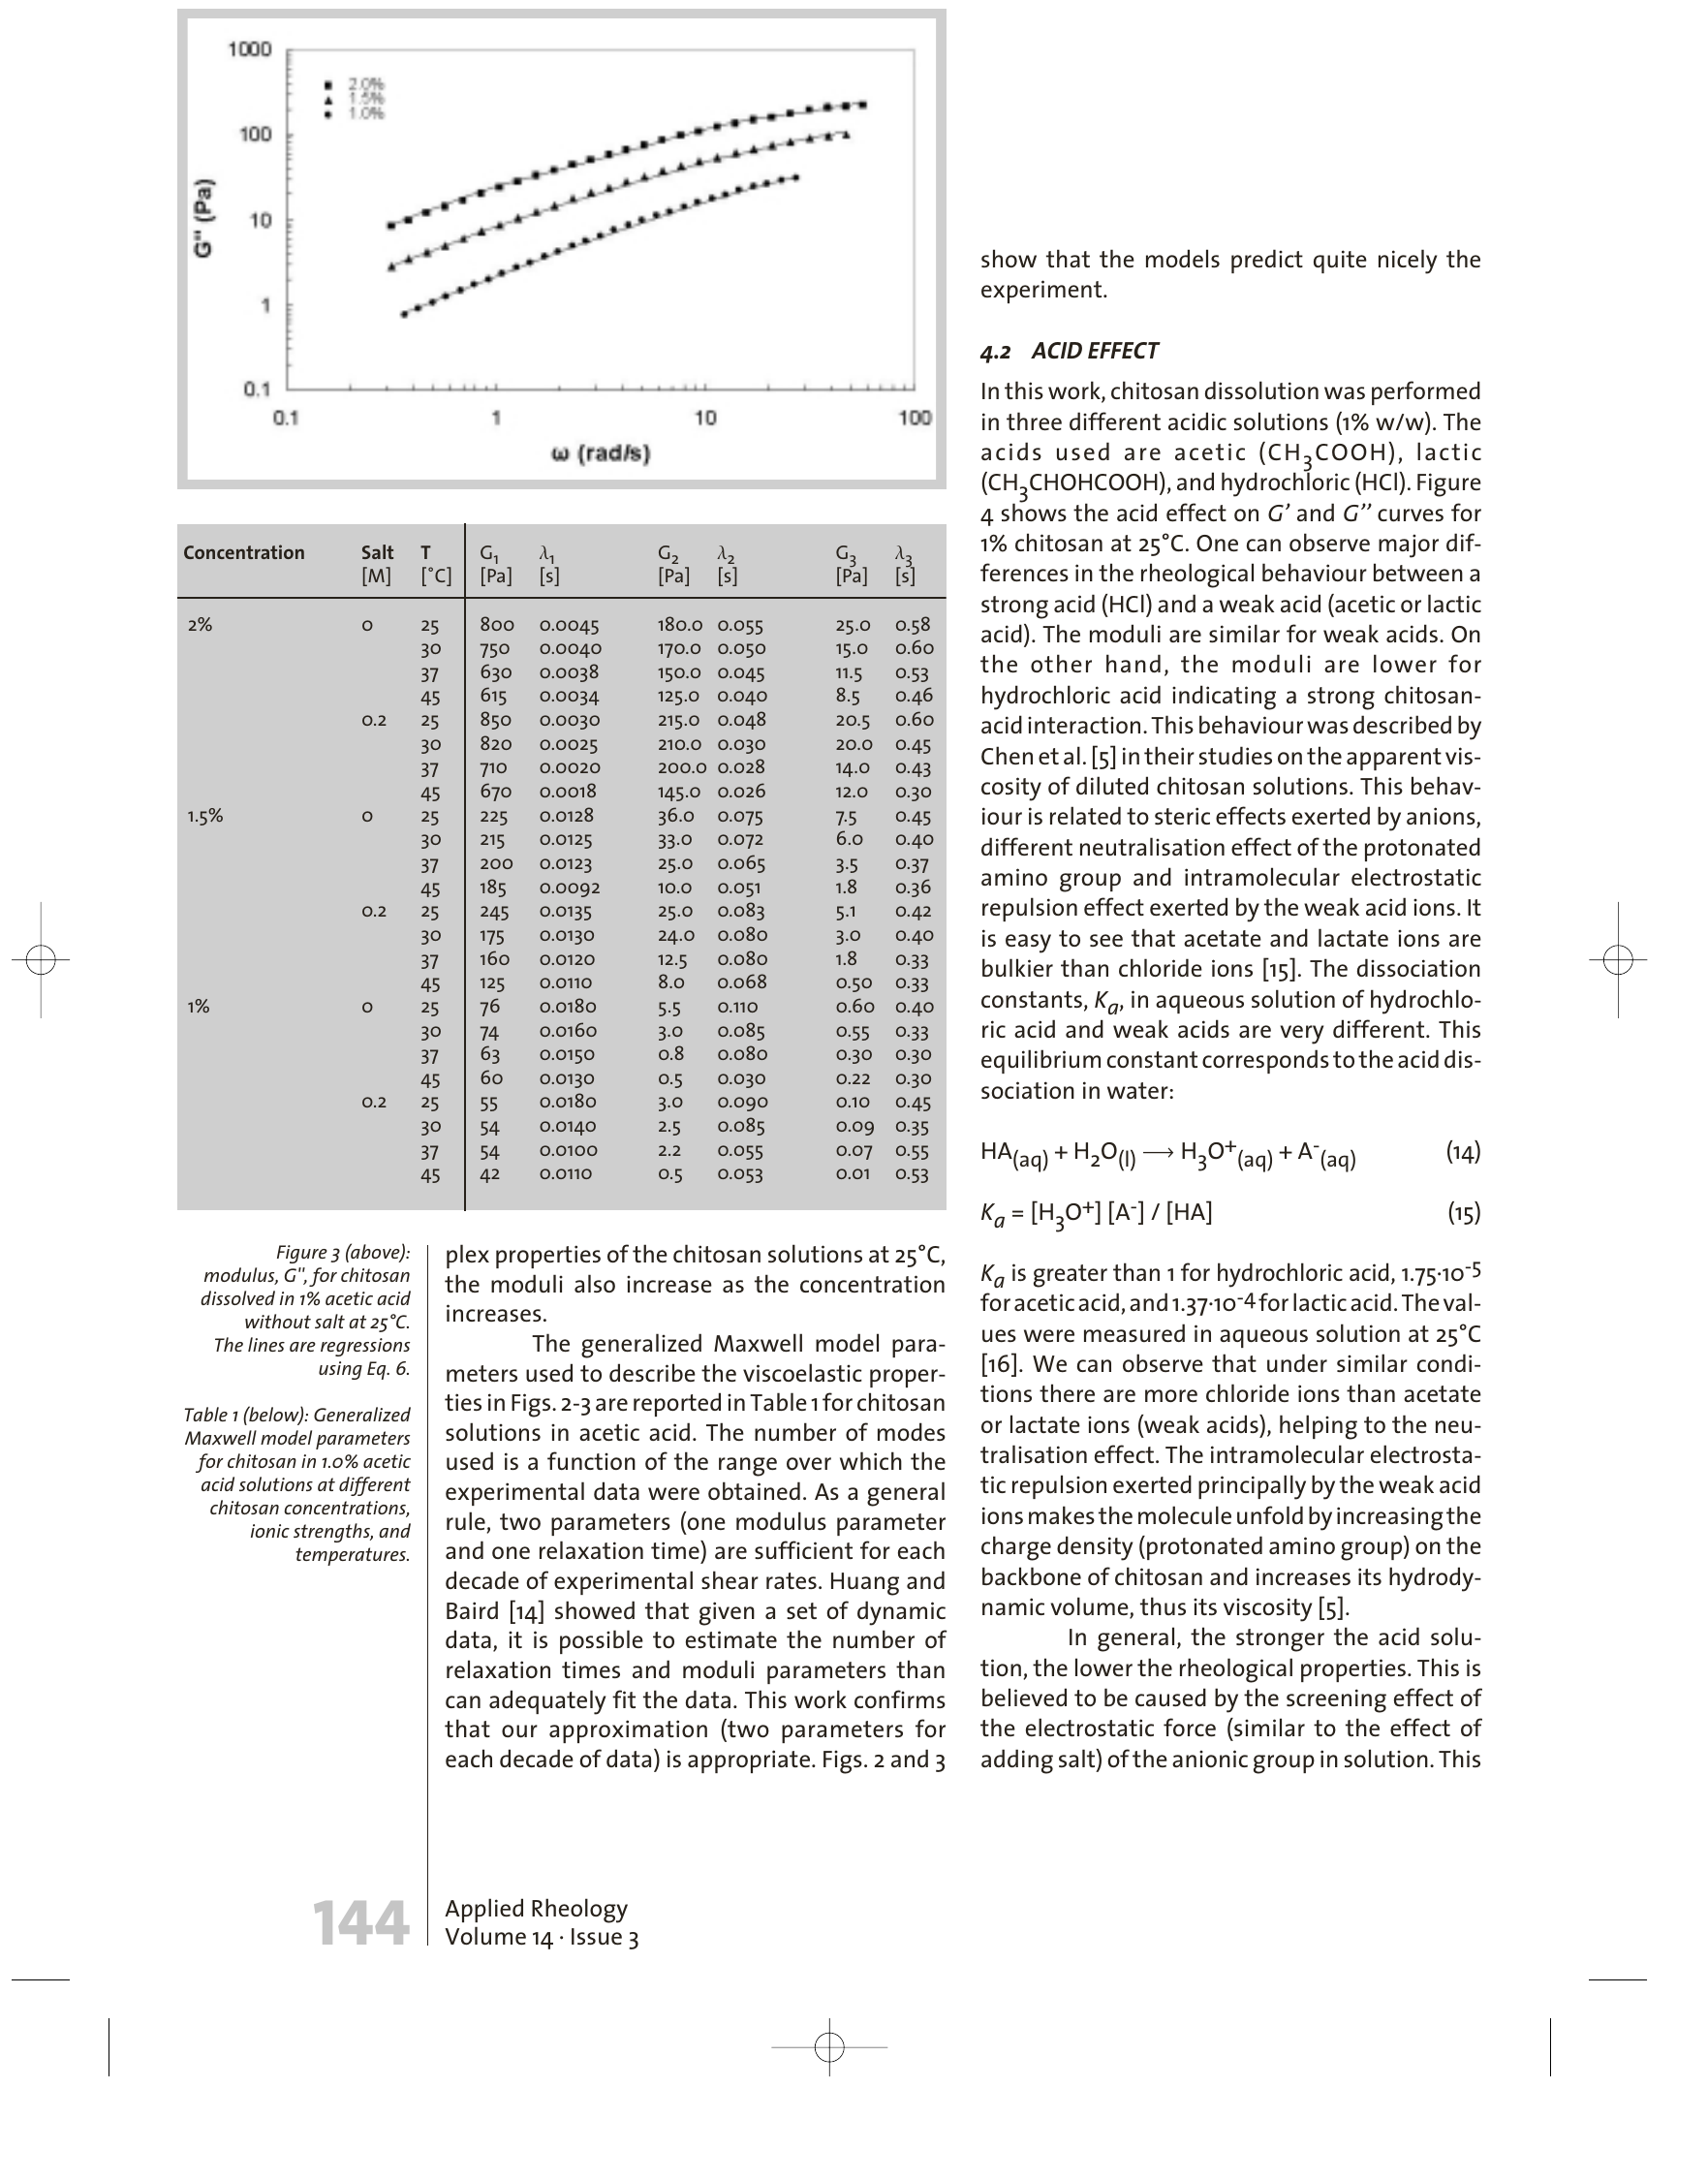
Figure 3 (above): modulus, G'', for chitosan dissolved in 1% acetic acid without salt at 25°C.